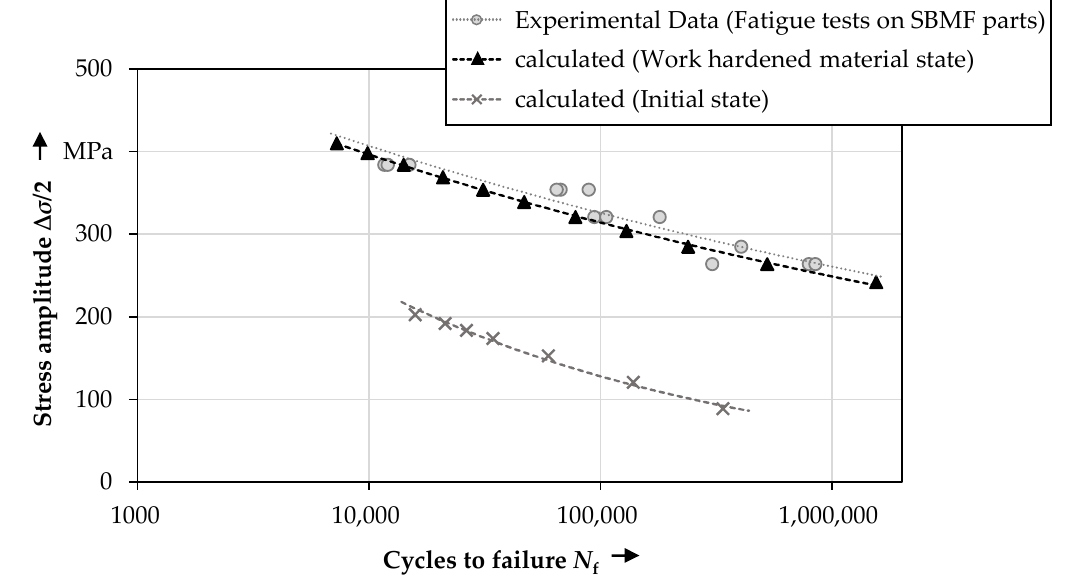
Figure 15. S-N-curves determined for the different material states.